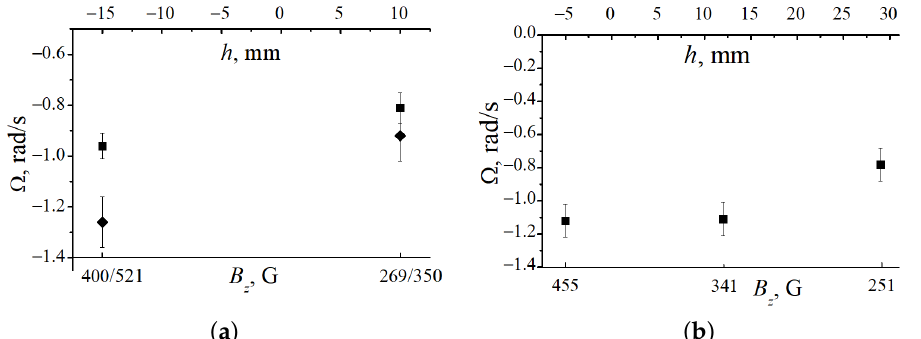
Figure 5. Angular velocities of dust structures in two ( a ) or three ( b ) striations, depending on their position h near the solenoid upper end. ( a ) p = 0.5 Torr; squares: I = 1.2 mA, structures are located in striation V ( h = − 15 mm, B = 400 G) and striation VI ( h = 10 mm, B = 269 G); rhombs: I = 1.3 mA, structures are located in striation VI ( h = − 15 mm, B = 521 G) and striation VII ( h = 10 mm, B = 350 G). ( b ) p = 1 Torr, I = 1.2 mA, structures are located in striation V ( h = − 5 mm, B = 455 G), striation VI ( h = 12 mm, B = 341 G) and striation VII ( h = 29 mm, B = 251